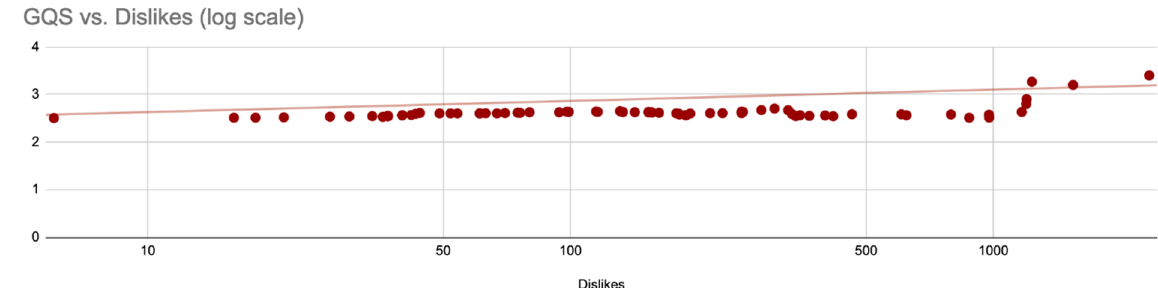
Figure A1. Likes were plotted on a log scale due to the typical distribution of this variable. When plotted against the GQS of the corresponding video, a positively sloped but almost horizontal line describes their relationship. This (non-)associa- tion seems to be statistically significant in a Spearman correlation (r = 0.29 [0.06; 0.49], p = 0.012). Note: the log-transfor- mation of the “Likes” variable is done here for ease of viewing and does not change the outcome of (non-parametric) statistical analysis.